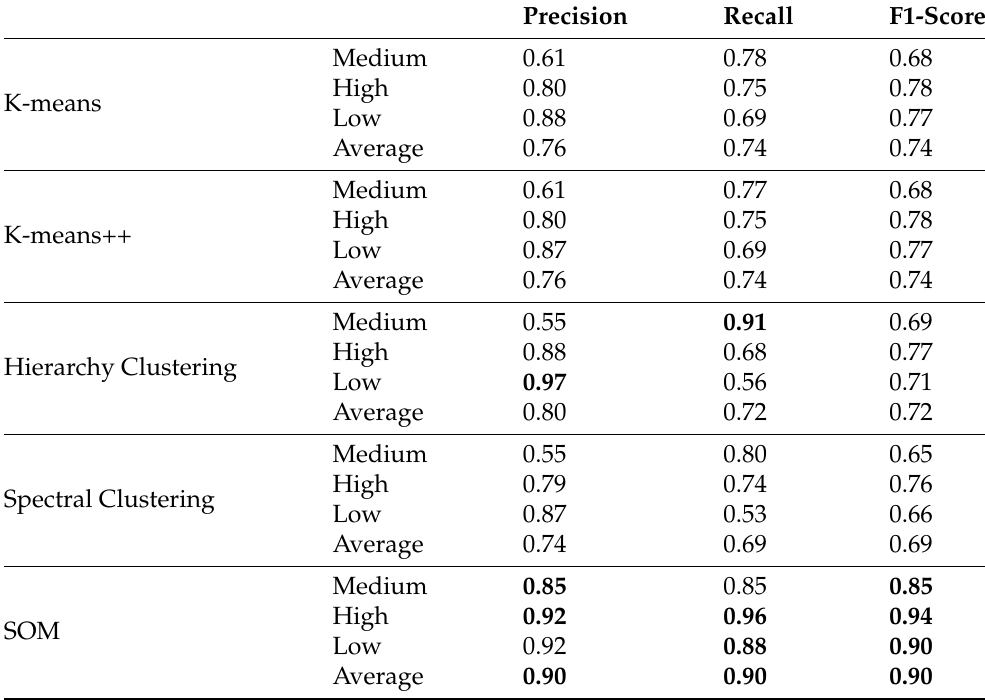
Figure 7. Confusion matrix using five different methods. Table 1. Summary of the results obtained using different clustering methods. The F1-score of high-, medium-, and low-quality data using SOM are the highest among all five methods. The bold numbers represent the highest value of each performance